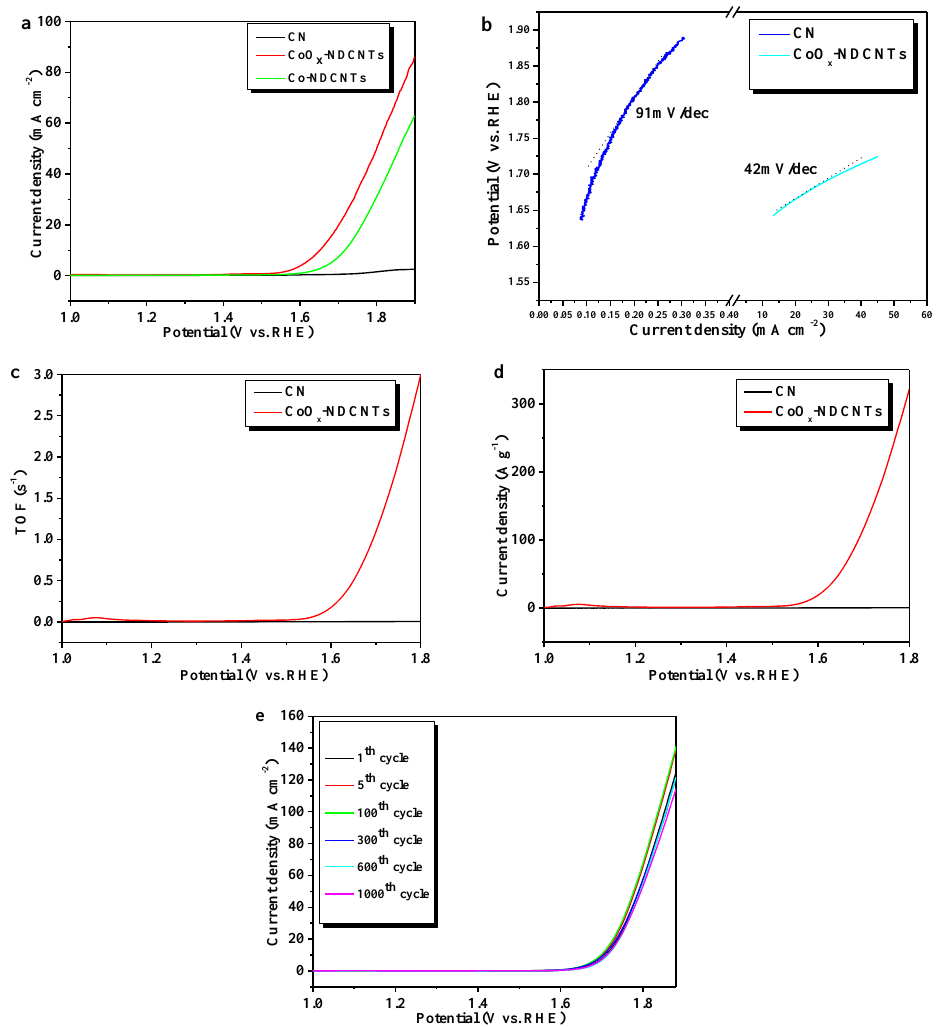
Figure 8. Electrochemical characterizations on oxygen evolution reaction (OER) activity ( a ) polarization curves, ( b ) tafel plots in 1 M KOH medium, ( c ) TOF plots with respect to applied potentials in 1M KOH electrolyte, ( d ) mass activity of diverse OER catalysts and ( e ) stability test of the CoO x -NDCNTs nanotube by long-term CV cycling.